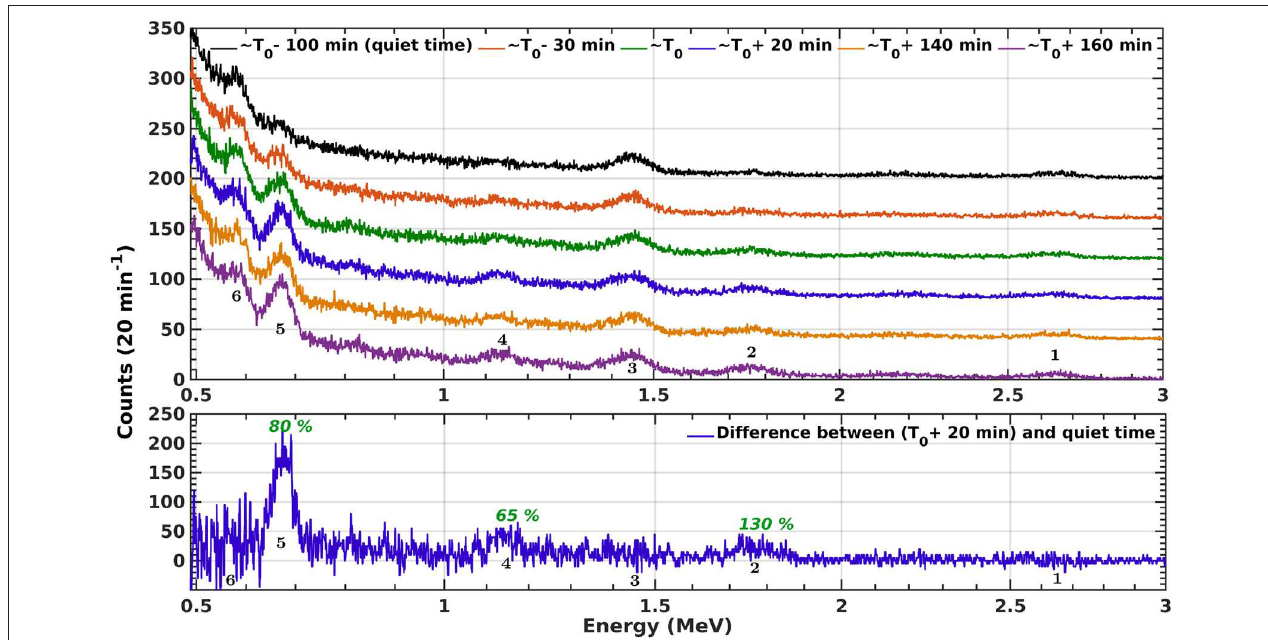
FIGURE 9 | With rain onset time as T 0 , the 20 min accumulation spectra at various instances are depicted in the upper panel. The difference in counts of various photopeaks during the rainfall ( T 0 + 20 min ) is shown in the lower panel along with the respective value of % change relative to the calm (no-cyclone) time